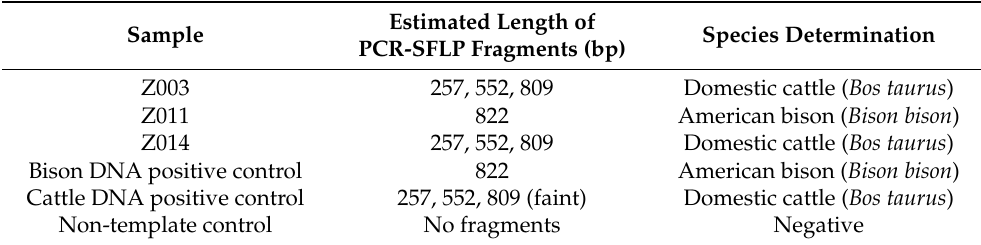
Table 3. Results of PCR-SFLP for bison products ( n = 3) that tested positive for domestic cattle with DNA barcoding. The satellite 1.711 PCR amplicon was digested with Taq I restriction enzyme to determine the species present in the